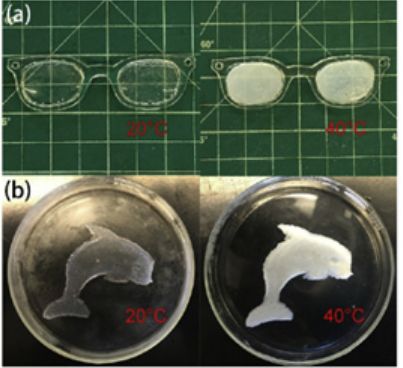
Figure 7. 3D-printed PNIPAm/CNF hydrogels at T = 20 ◦ C ( left ) or T = 40 ◦ C ( right ) in the shape of lenses (panel a ) or a dolphin (panel b ). Reprinted from [114], with permission.